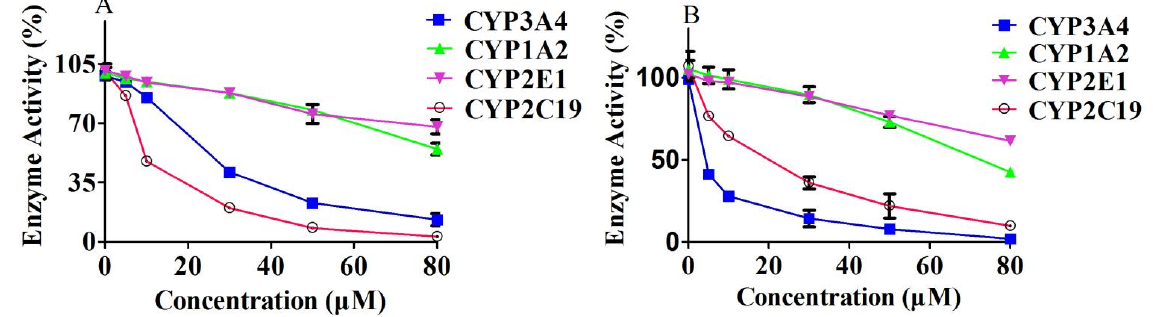
Figure 6. The effects of curcumin ( A ) or germacrone ( B ) on CYP3A4, 1A2, 2E1, and 2C19 activity in in vitro ( n = vitro ( n = 3).